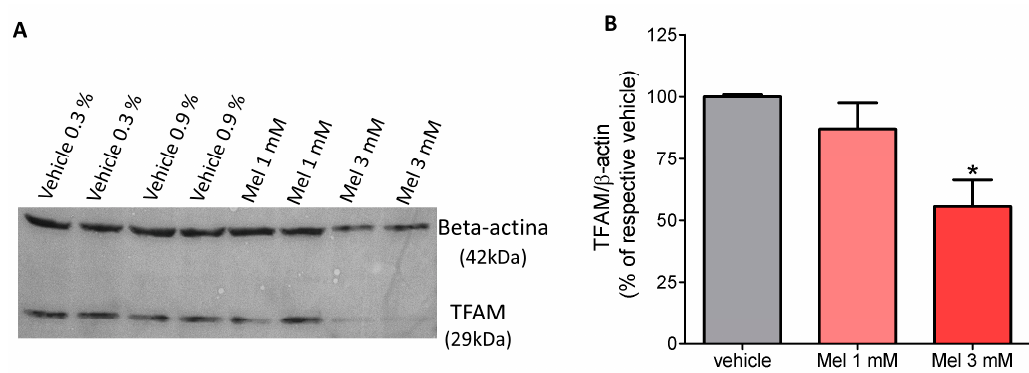
Figure 1. Melatonin inhibits the expression of mitochondrial transcription factor A (TFAM), TFB1M, and TFB2M—Cultured U87MG cells were incubated with melatonin (1 mM or 3 mM) for 72 h, and the medium was exchanged every 24 h. The relative mRNA expression levels of each gene were quantified by qRT-PCR using the geometric mean of the following normalizing genes: Hypoxanthime phosphoribosyl transferase (HPRT), glucuronidase-beta (GUS-B), and TATA-Box binding protein (TBP) [27]. The data are expressed as the relative quantification (2 −ΔΔ Ct ) compared to the vehicle- treated groups (ethanol 0.3% or 0.9%). Gene expression did not differ in cells treated with vehicle or 0.3% and 0.9% ethanol, and these groups were represented as a single group. From left to right are presented the results for TFAM ( A ), TFB1M ( B ), and TFB2M ( C ). * p < 0.05, tested with an analysis of variance followed by the Bonferroni post-hoc correction using GraphPad Prism ® version 5, comparing the effect of melatonin to the vehicle group.